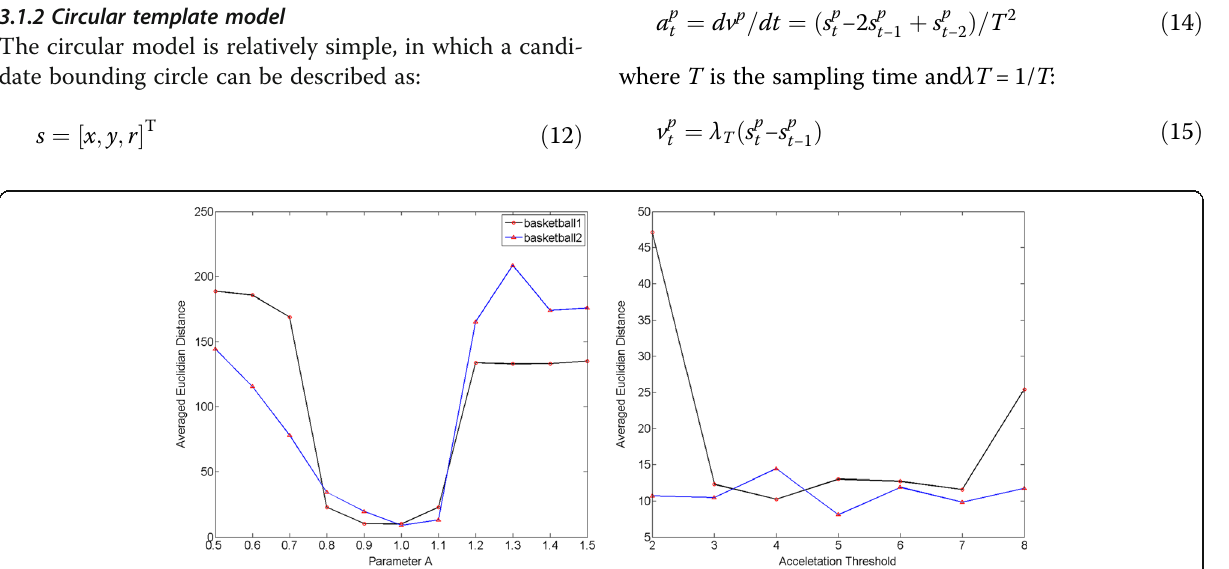
Fig. 10 The tracking results using different parameters